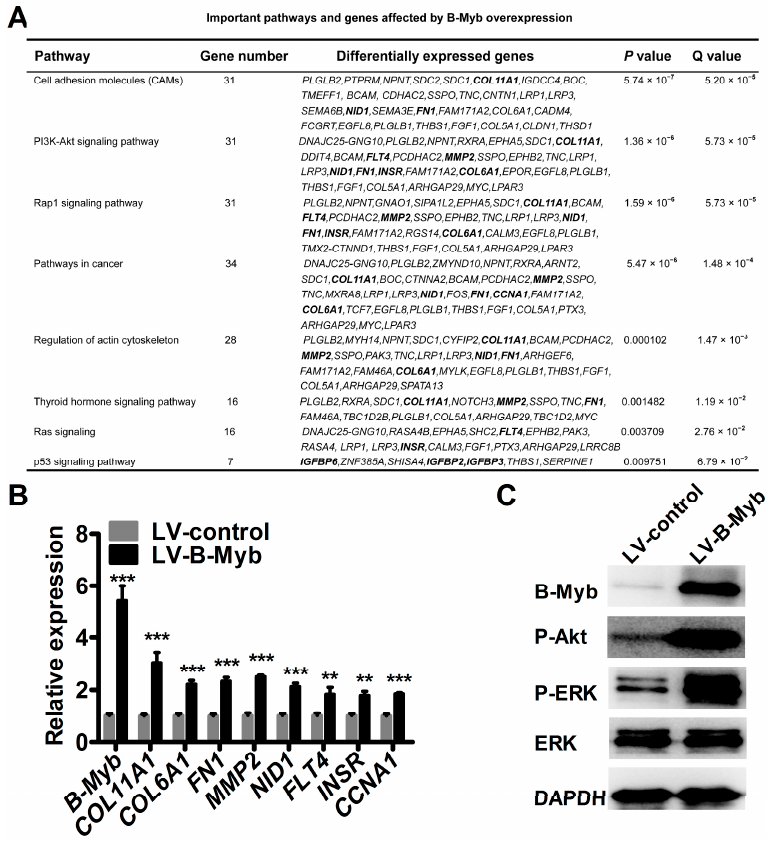
Figure 7. B-Myb overexpression affects various downstream genes and important pathways. ( A ) Important pathways and genes affected by B-Myb overexpression. The stable control (LV-control) and B-Myb overexpression (LV-B-Myb) H1299 cells were subjected to RNA-sequencing (RNA-seq) analysis. Differentially expressed genes between LV-control and LV-B-Myb cells were filtered and subjected to Gene Ontology and pathway analysis, as described in the Materials and Method sections. ( B ) Validation of differentially expressed genes by qRT-PCR. ( C ) B-Myb overexpression activates phosphorylation of ERK and Akt. Exponentially grown LV-control and LV-B-Myb cells were collected and subjected to immunoblot analysis with the indicated antibodies. ** p < 0.01, *** p < 0.001; GAPDH: glyceraldehyde-3-phosphate dehydrogenase.